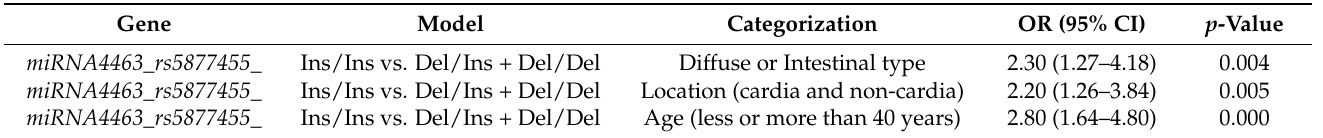
Table 5. Significant associations between INDEL miRNA4463 and clinical variants in GC. Gene Model Categorization OR (95% CI) p -Value miRNA4463_rs5877455_ Ins/Ins vs. Del/Ins + Del/Del Diffuse or Intestinal type 2.30 (1.27–4.18) 0.004 miRNA4463_rs5877455_ Ins/Ins vs. Del/Ins + Del/Del Location (cardia and non-cardia) 2.20 (1.26–3.84) 0.005 miRNA4463_rs5877455_ Ins/Ins vs. Del/Ins + Del/Del Age (less or more than 40 years) 2.80 (1.64–4.80)